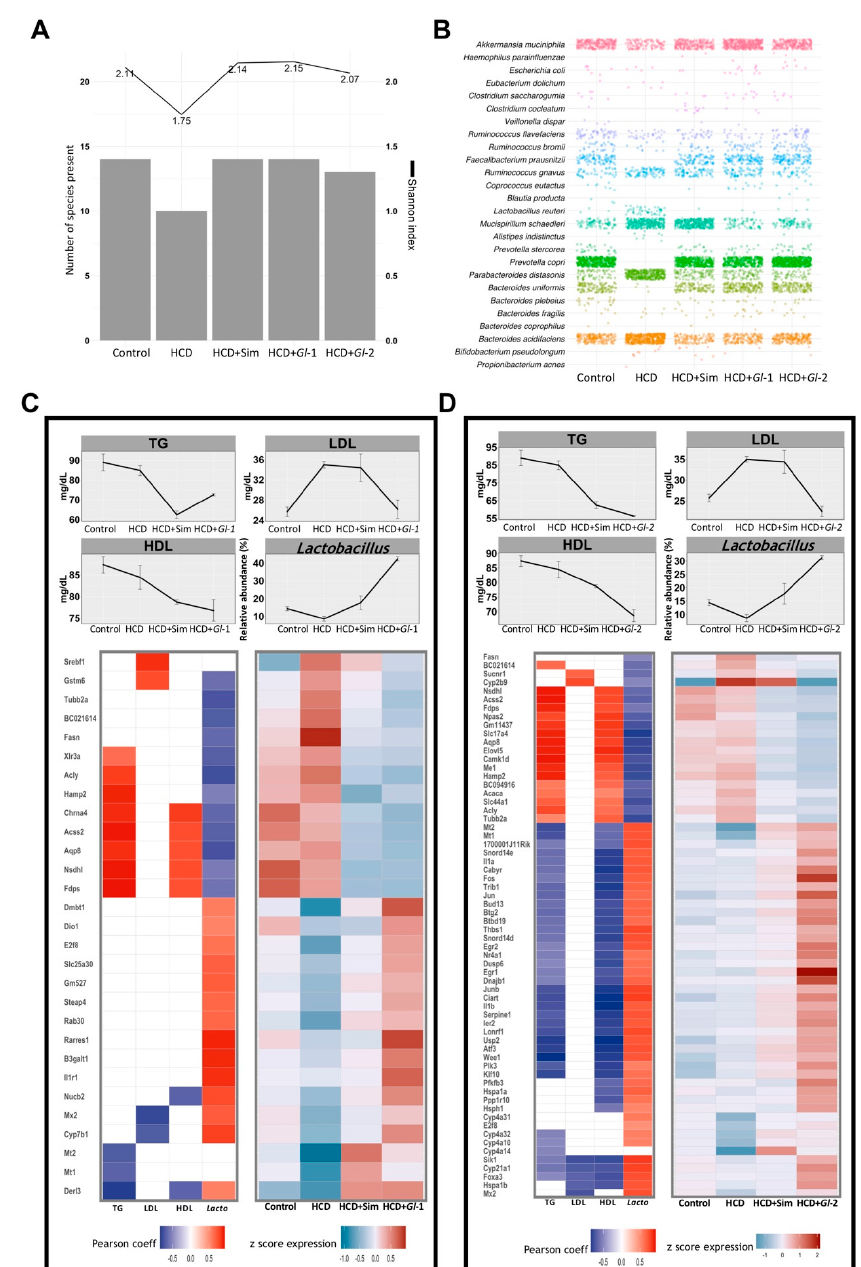
Figure 6. Hepatic genes modulated by Ganoderma lucidum extracts ( Gl -1, Gl -2) correlated with biochemical parameters and relative abundance of Lactobacillus in the gut microbiome. ( A ) Gut bacterial richness at species level according to the Shannon index (line plot) and the number of detected species (bar plot) in each experimental group. ( B ) Frequency grid plot showing relative abundance of bacterial species in the gut microbiota grouped by experimental condition. ( C , D ) Pearson cor- relation between expression levels of genes significantly modulated by Gl -1 or Gl -2 extracts (lower panel) and blood levels (mg/dL) of TG, LDL, HDL, and the relative abundance (%) of Lactobacillus in gut microbiome composition (upper panel). The left heatmap shows significant correlations (Pearson coefficient > 0.5, in red; < − 0.5, in blue; FDR < 0.1) between Gl -1 ( C ) or Gl -2 ( D ) responsive genes and their variables at the top. The right heatmap in Gl -1 ( C ) or Gl -2 ( D ) represents expression levels of correlated genes in each experimental condition (low to high expression scale is indicated in blue and red, respectively). TG: triglycerides. HDL: high-density lipoprotein cholesterol. LDL: low-density lipoprotein cholesterol. HCD: high-cholesterol diet. HCD + Sim = high-cholesterol diet + simvastatin. HCD + Gl -1 = high-cholesterol diet + Gl -1 extract. HCD + Gl -2 = high-cholesterol diet + Gl -2